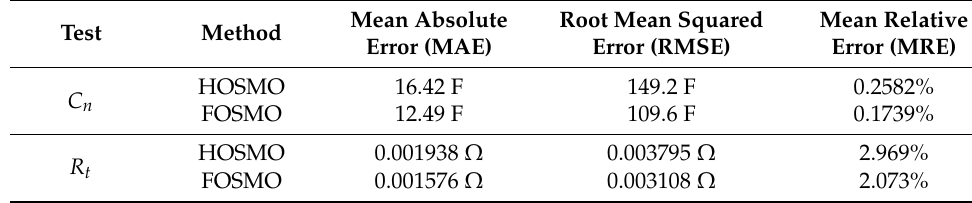
Table 3. The measurement error in SoH